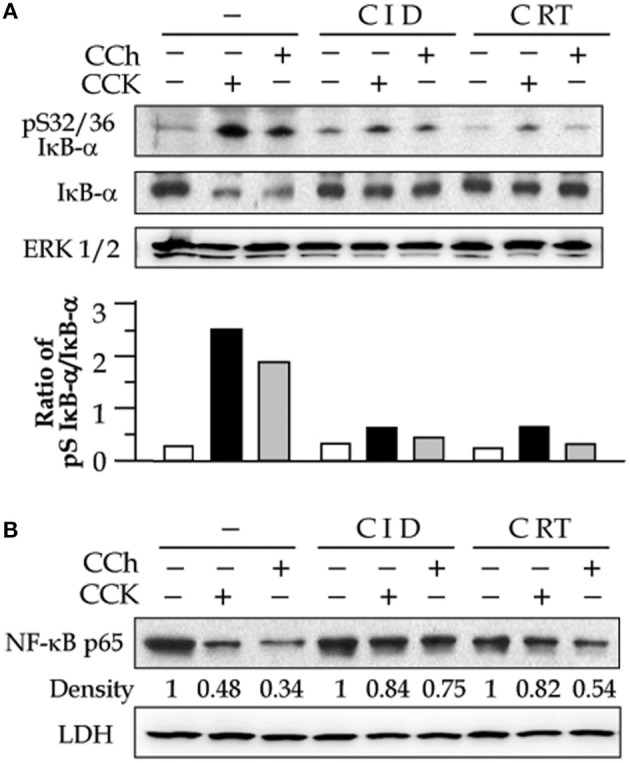
PKD inhibitors decrease secretagogue-induced IkB-α phosphorylation and degradation and nuclear translocation of NF-κB. Rat pancreatic acinar cells were incubated with or without CID (25 μM) or CRT (10 μM) for 2 h prior to 100 nM CCK or 200 μM CCh treatment for an additional 30 min. (A) IκB-α phosphorylation and degradation were measured in cell cytosolic extract by Western blot. ERK1/2: for loading control. The Western blot results of IκB-α phosphorylation and degradation was quantified and expressed as the ratio of pS IκB-α to IκB-α in the bar figures. (B) Western blot analysis of NF-κB P65 in cell cytosolic extract. LDH: for cytosolic extract loading control. The results were representative of two independent experiments.